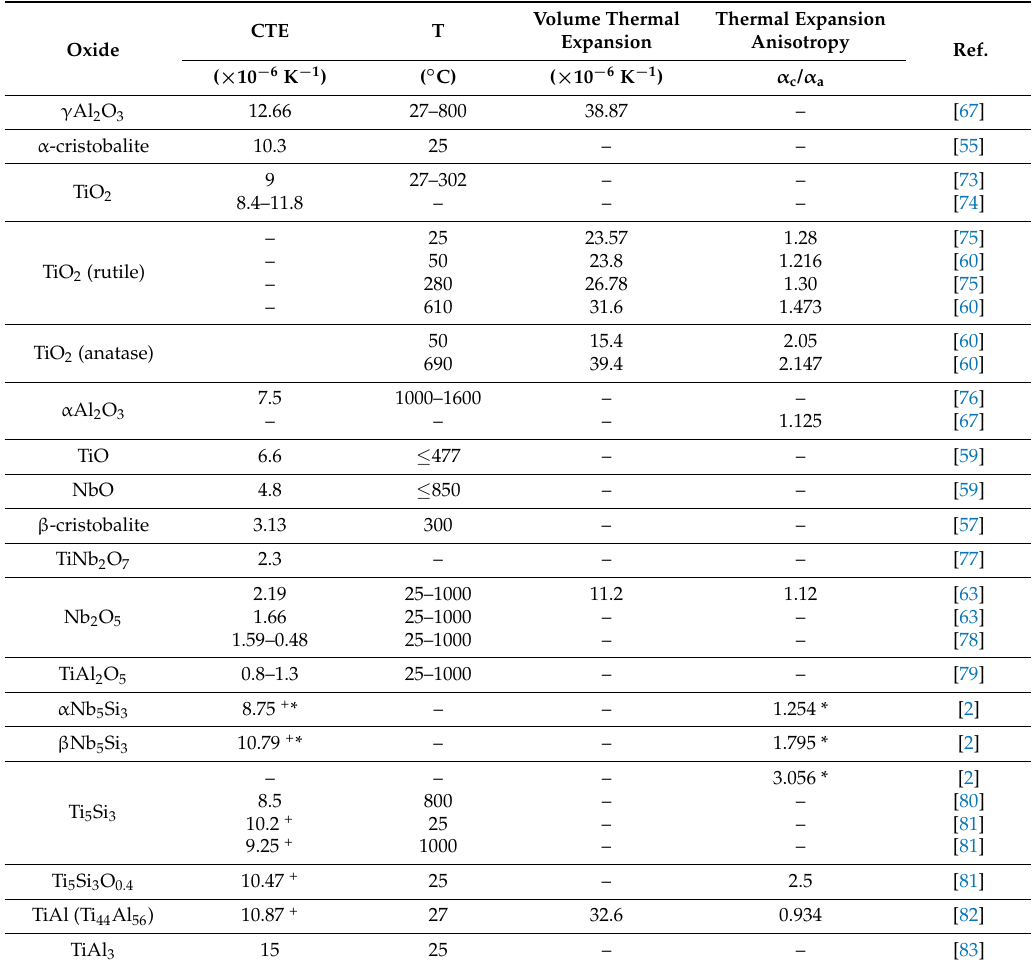
Table 2. Coefficients of thermal expansion, volume thermal expansion, and thermal expansion anisotropy ( α c / α a ) of oxides, silicides and aluminides.